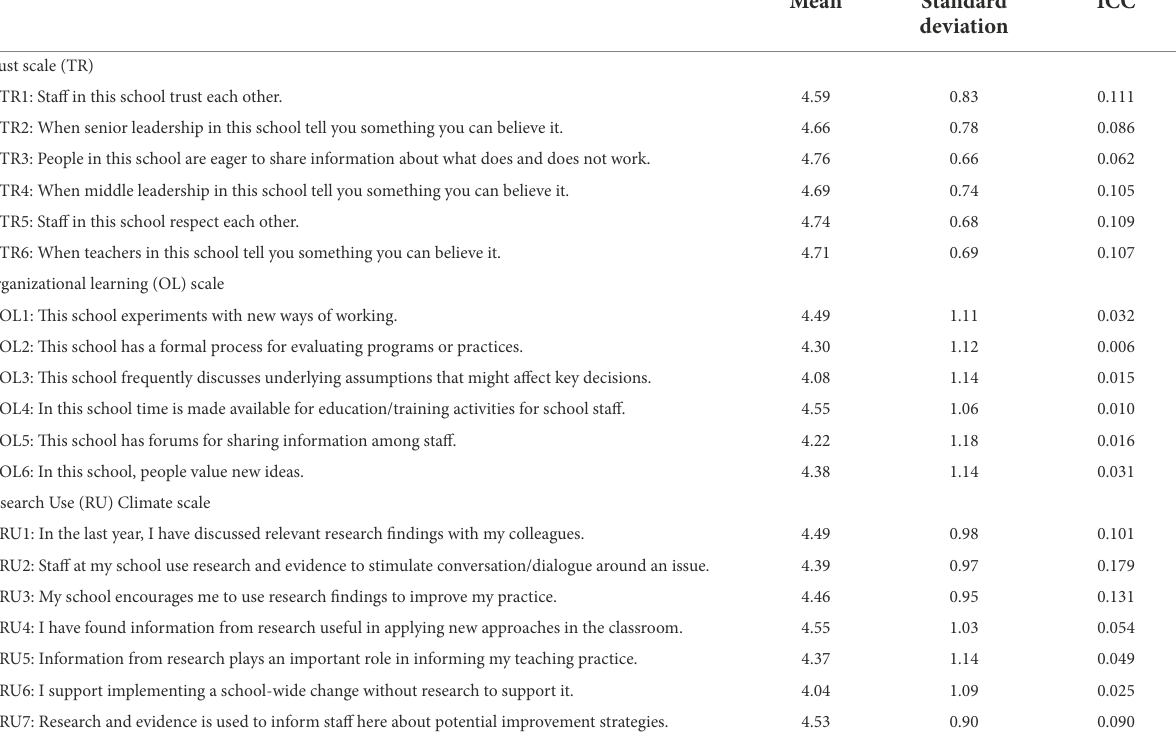
TABLE 1 Overview of the items in the self-assessment scales used.